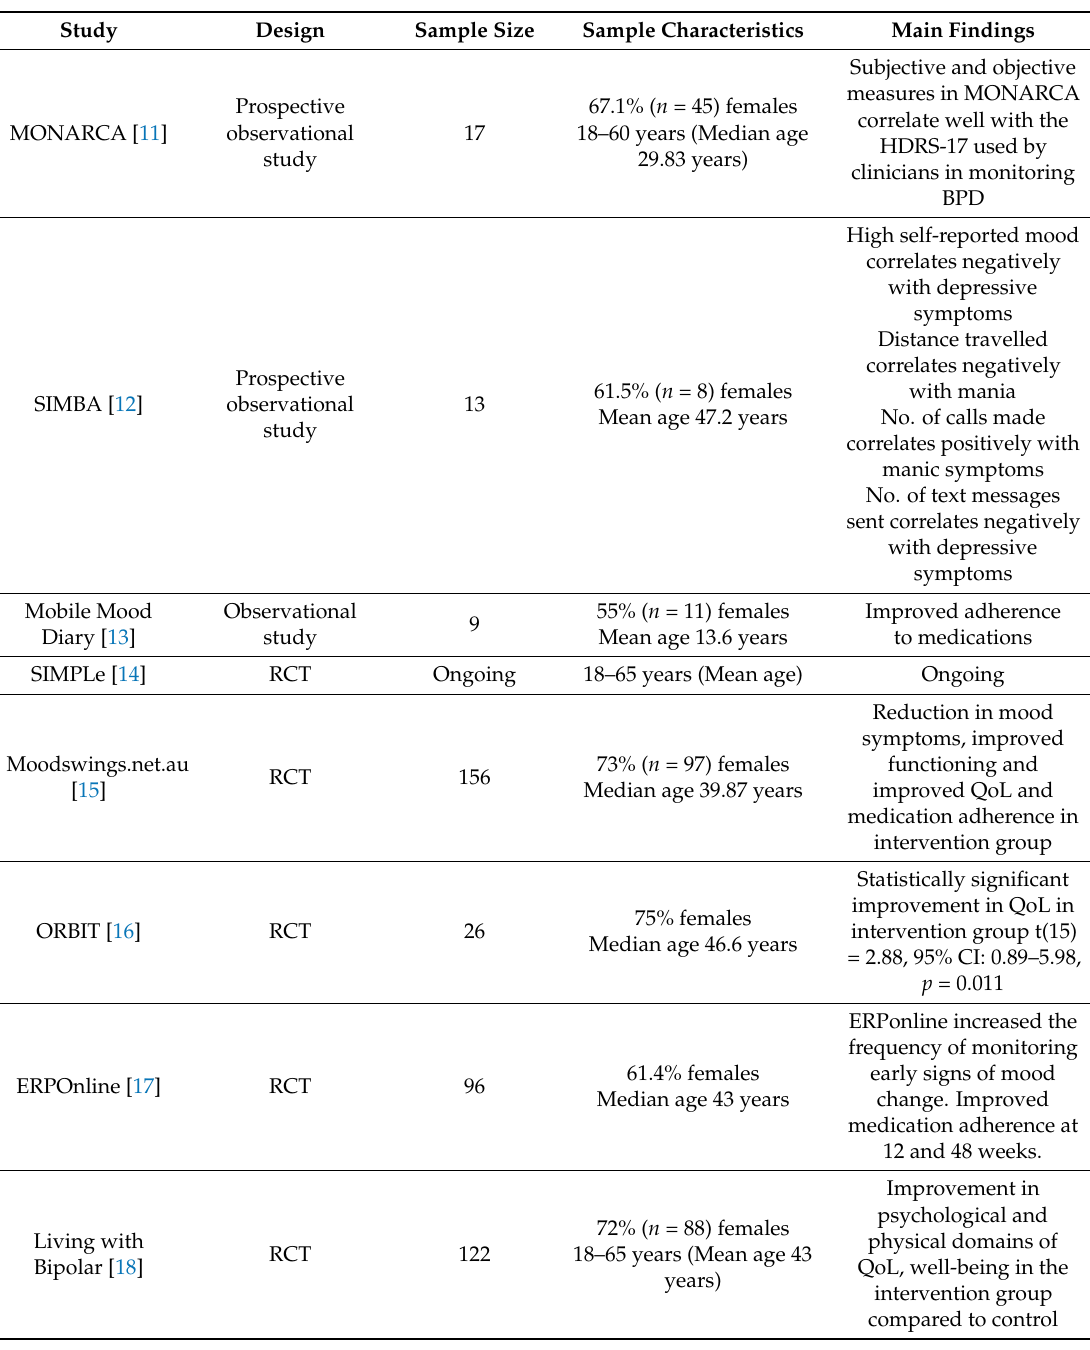
Table 1. Studies on digital platforms used in the assessment, monitoring and management of